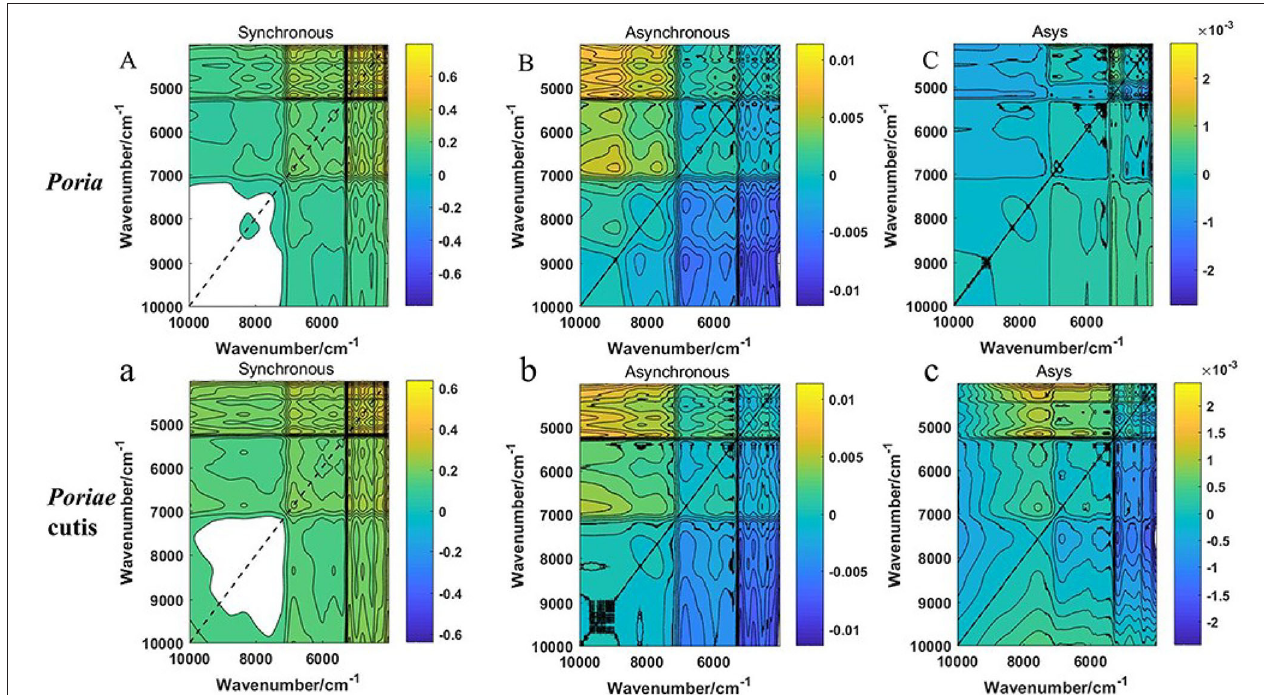
FIGURE 4 | (A–C) Synchronous, asynchronous 2DCOS and i2DCOS of W.cocos in Poria; (a–c) Synchronous, asynchronous 2DCOS and i2DCOS of W.cocos in Poriae cutis.